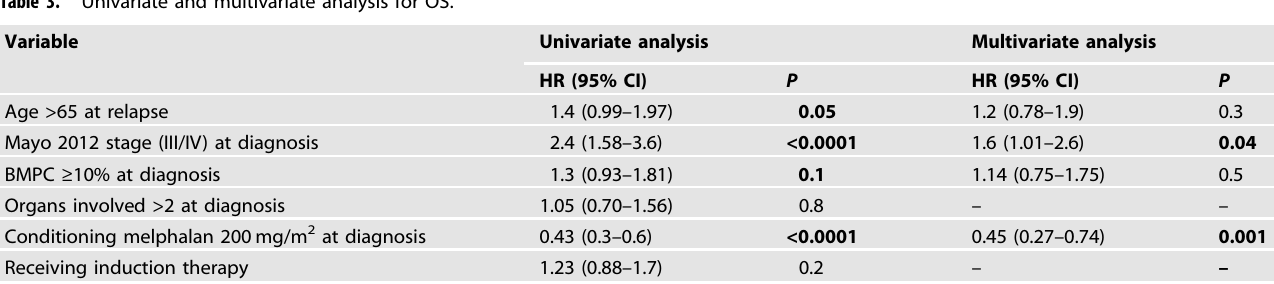
OS overall survival, HR hazard ratio, CI con fi dence interval, BMPC bone marrow plasma cell. The bold values indicate a statistically signi fi cant result.